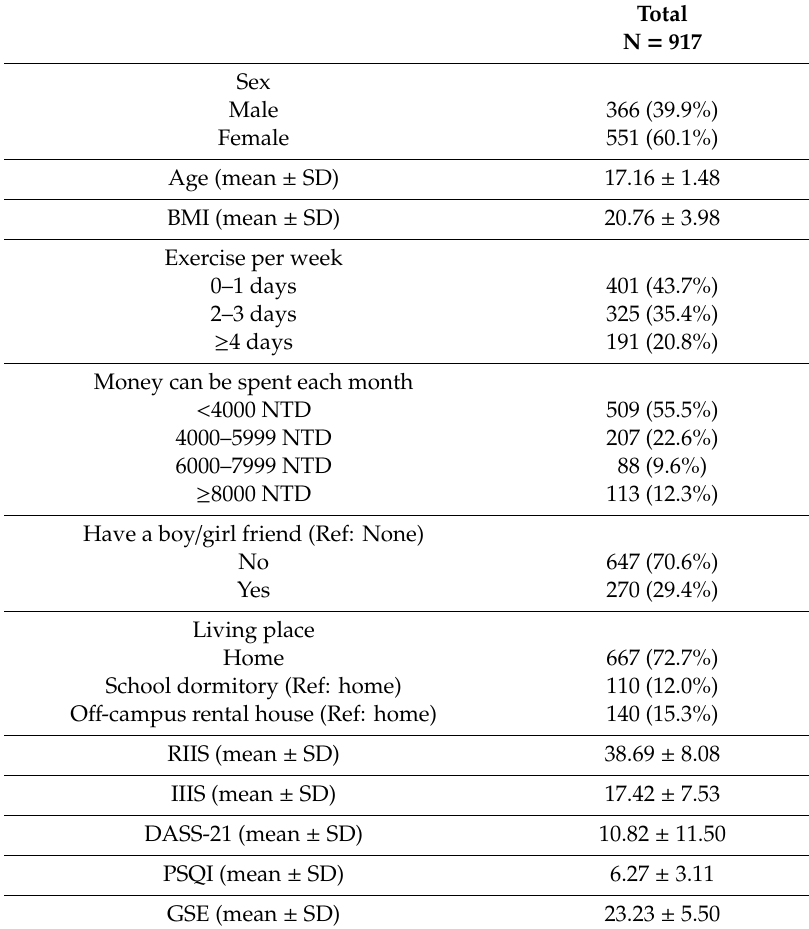
Table 1. Participants’ basic